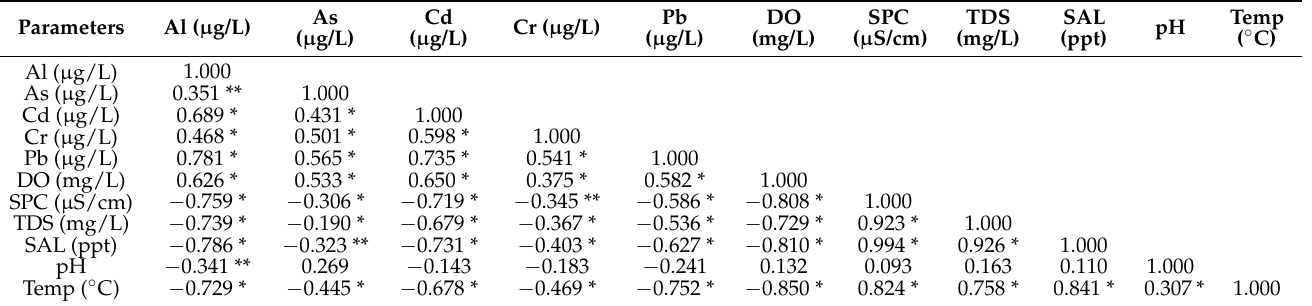
Table 4. Correlation matrix a among water quality parameters using principal component analysis.